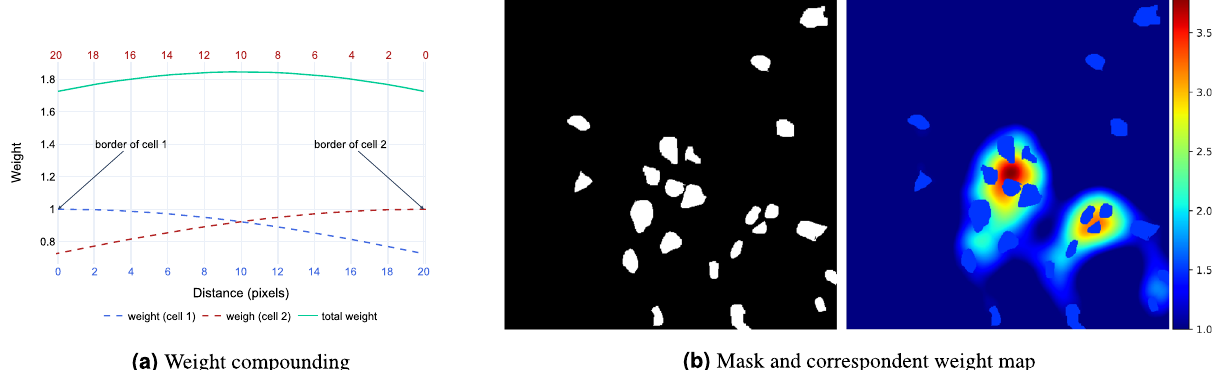
Figure 3. Weight map. 3a shows the weight factors of background pixels between cells according to Eq. (1). The dashed curves depict the weights generated by single cells as a function of the distance from their borders. The green line illustrates the final weight obtained by adding individual contributions. In 3b, a target mask and the corresponding weight